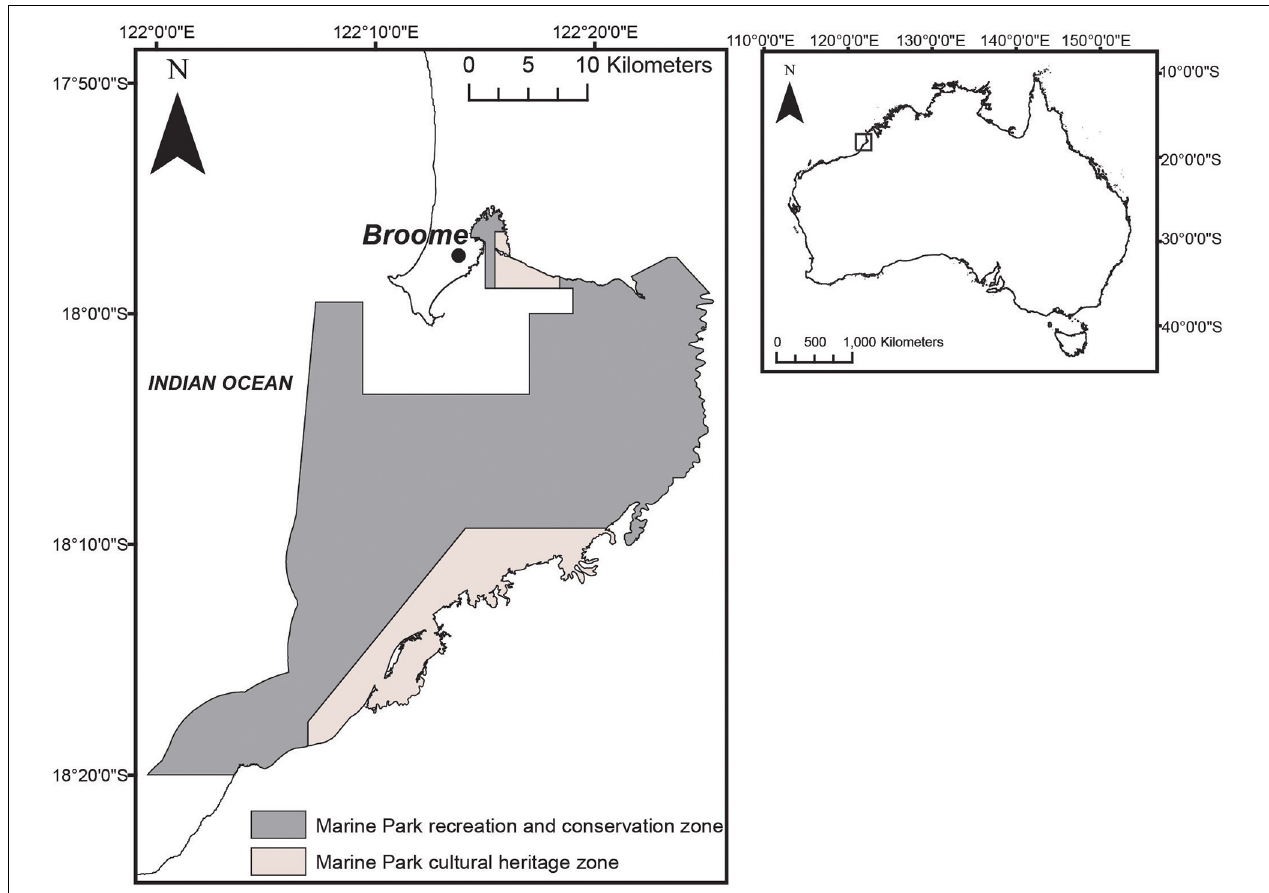
FIGURE 1 | (Left) Yawuru Nagulagun with boundaries of the Yawuru Nagulagun Roebuck Bay Marine Park (YNRBMP) illustrated, including zonation. (Right) Map of Australia illustrating the location of Yawuru Nagulagun (pictured inside